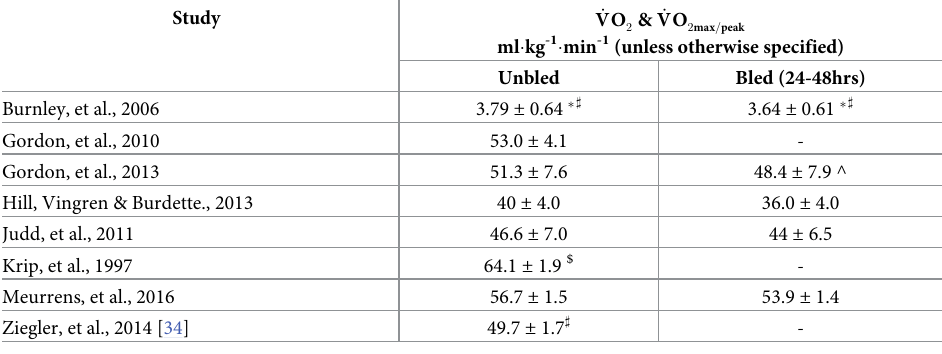
Table 2. _ VO values pre donation (Unbled) in all 8 studies are shown with post donation (Bled) values for the 2 max studies that collected 24–48 hrs data. Gordon, et al. [33] was a submaximal test post donation in the moderate and heavy domains involving oxygen uptake kinetics and thus the values are not reported in this